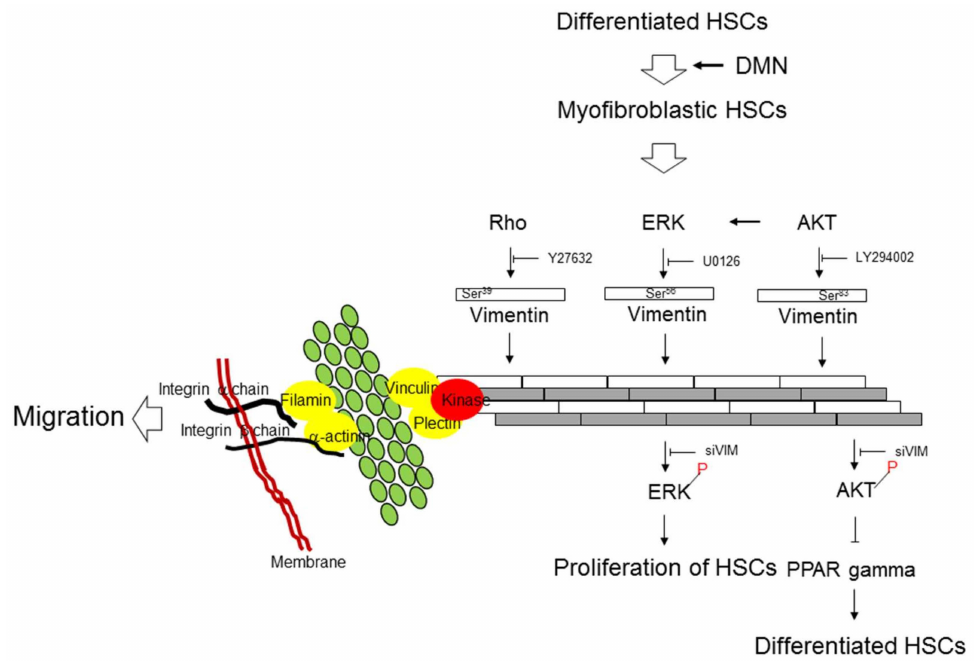
Figure 6. Schematic diagram indicates that the interaction between vimentin and specific signaling pathways are critically modulating the proliferation, di ff erentiation, and migration of HSCs during liver fibrosis through the particular phosphorylated sites of